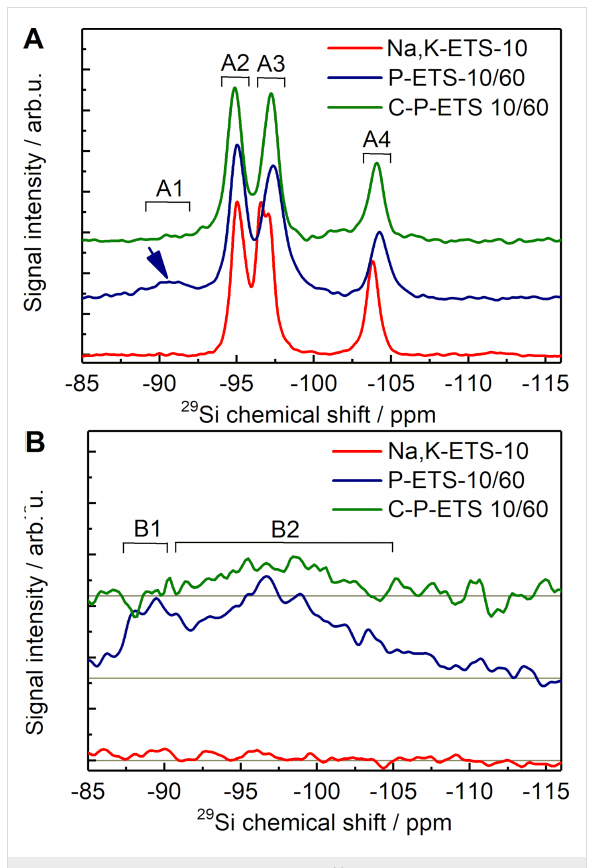
Figure 13: The HPDEC (A) and CP (B) 29 Si MAS NMR spectra ob- tained for Na,K-ETS-10 (red), P-ETS-10/60 (blue) and C-P-ETS 10/60 (green) at 12 kHz and 298 K. The arrow in (A) indicates a detectable signal centered at 90 ppm.